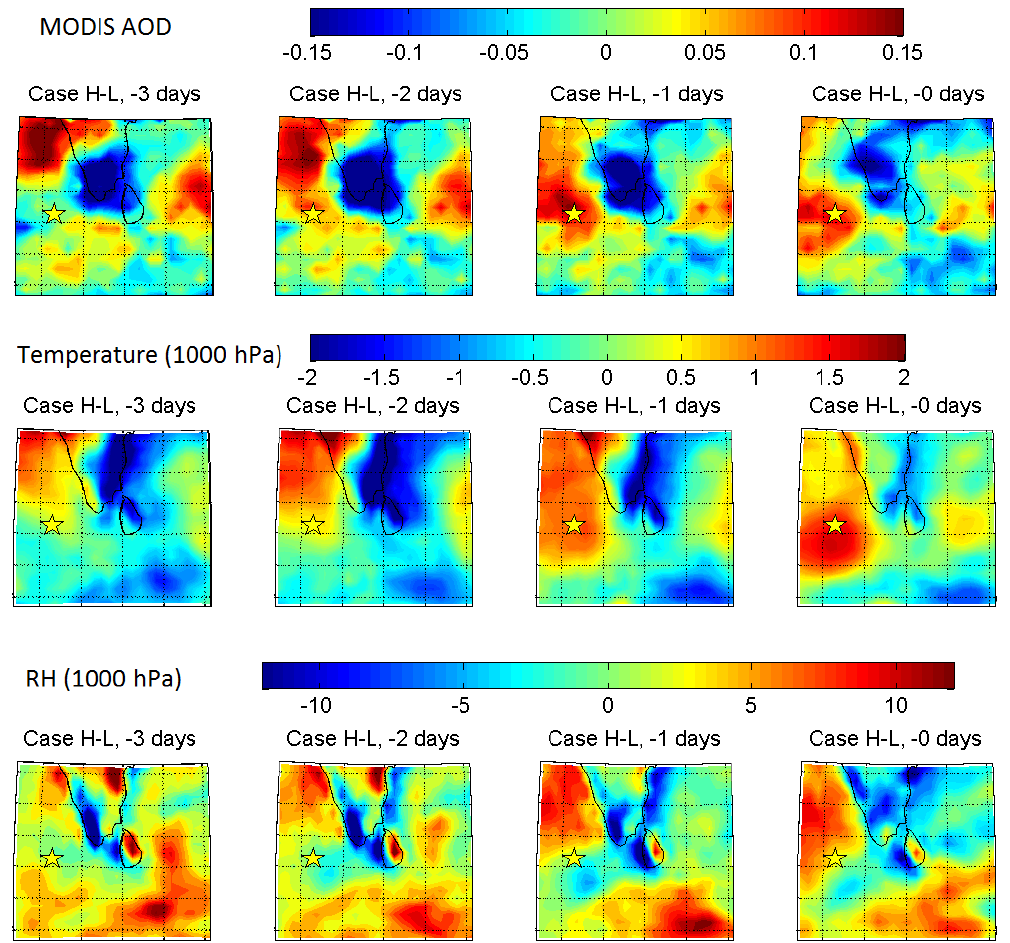
Figure 11. The evolution of the difference in high- minus low-pollution conditions for MODIS AOD (top row) and ECMWF temperature (middle row) and relative humidity (bottom row) at 1000hPa (approximately 75m) for dry days as identified in Table 1. The 1-day lag between maximum relative humidity and the maxima in both AOD and temperature is evident in the day-to-day progression. Average Case L and Case H conditions overlaid with wind fields are shown in Figs.